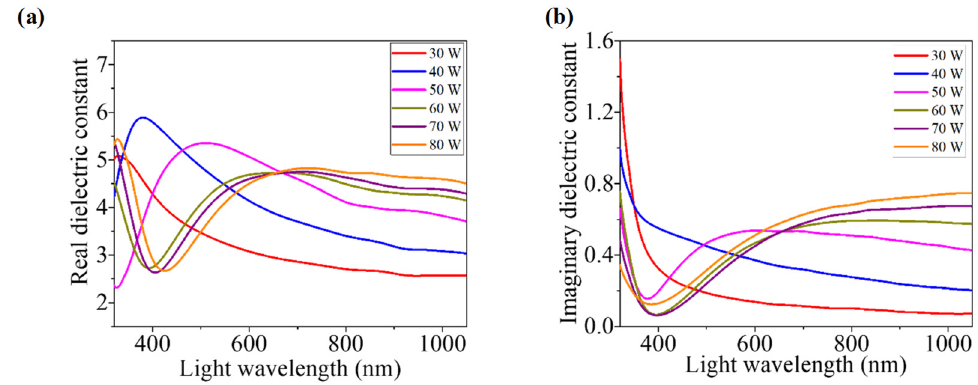
Figure 7. Light-dependent variation in: ( a ) real dielectric constant and ( b ) imaginary dielectric constant for different WO x films developed at different powers.